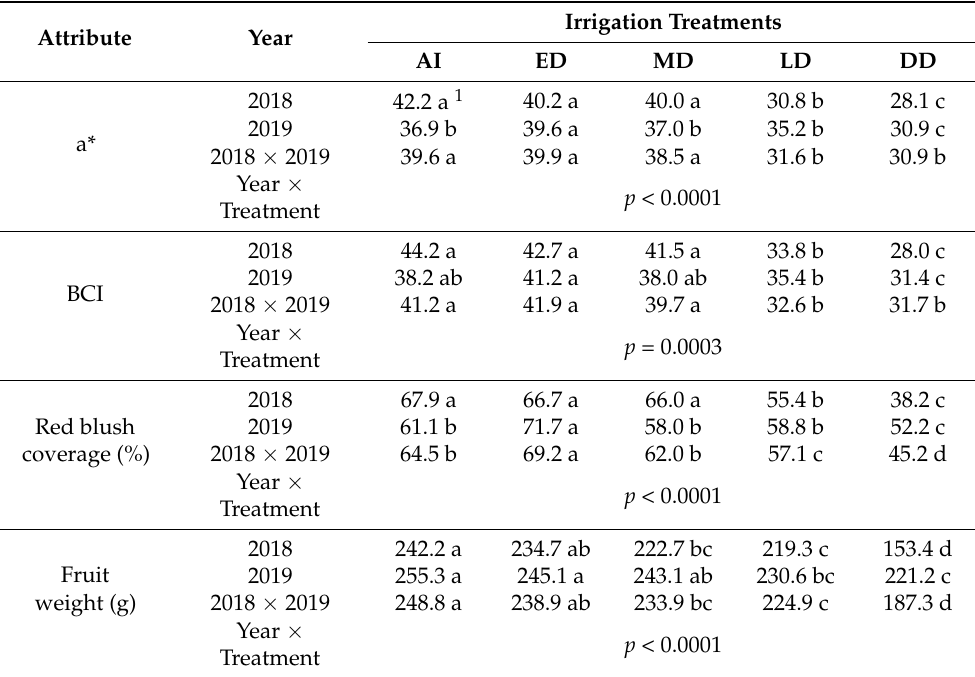
Table 2. Effects of regulated irrigation reductions on the blush color profiles and fruit weight of Ambrosia™ apples at harvest in different years.